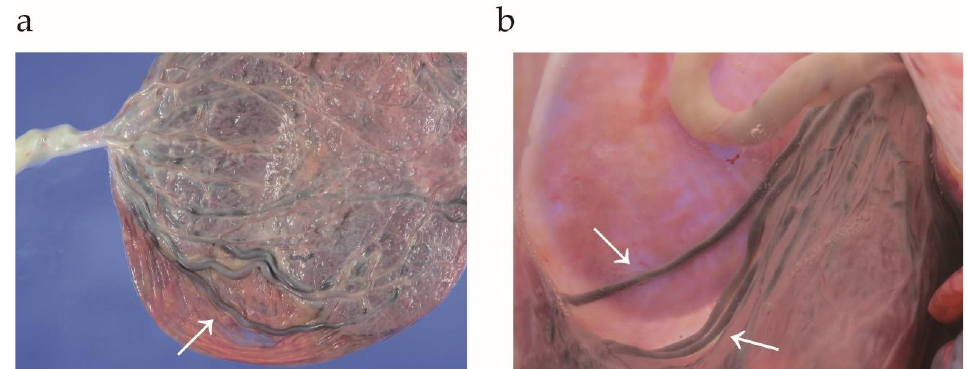
Figure 1. Gross images of type III vasa previa. Reproduced and updated data from Clin Case Rep. 2019; 7: 2263 – 2264. Hara et al. [39] with copyright permission. ( a ) Marginal cord insertion with an unprotected cord vessel running along the extraplacental membrane (white arrow). ( b ) The placenta and membranes were filled with water to visualize the 3D images of the fetal vessels. The vessels indicated with white arrows were running near the internal cervical os and were diagnosed as vasa previa.